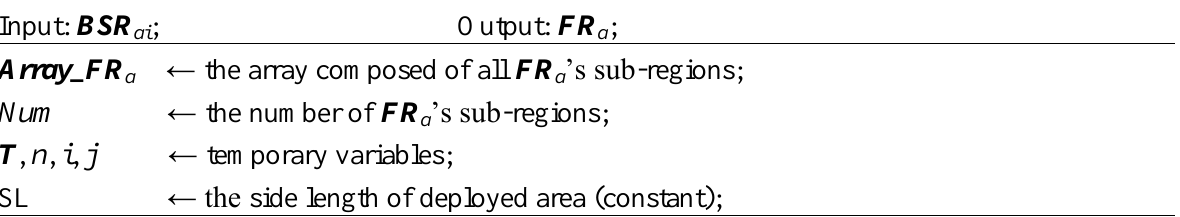
Figure B. Pseudo-codes of determining FR